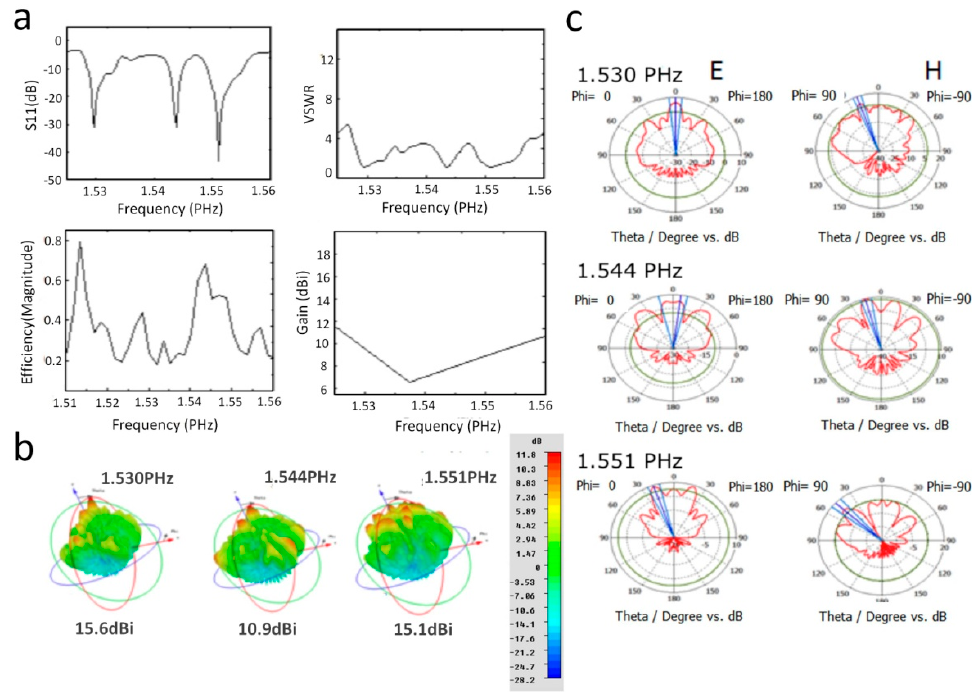
Figure 2. ( a ) Simulated resonance curves (1.525–1.575 PHz) of Passeriformes feather barbule model. The resonance spectrum has three resonance peaks at 1.530 PHz, 1.544 PHz, and 1.551 PHz frequencies. In the right upper panel, the average value of VSWR is almost equal to 1 at all resonance frequencies. High efficiency (65%) is observed at the third resonance peak, 1.544 PHz (bottom, left panel). The created structure in the bottom right panel has a positive gain at resonance peaks. ( b ) Directivity values are 15.6 dBi, 10.9 dBi, and 15.1 dBi at 1.530 PHz, 1.544 PHz, and 1.551 PHz resonance peaks, respectively. ( c ) The variation of E and H radiation patterns at resonance frequencies is shown. Table 1. The thickness of different layers in the simulated feather [23,24].